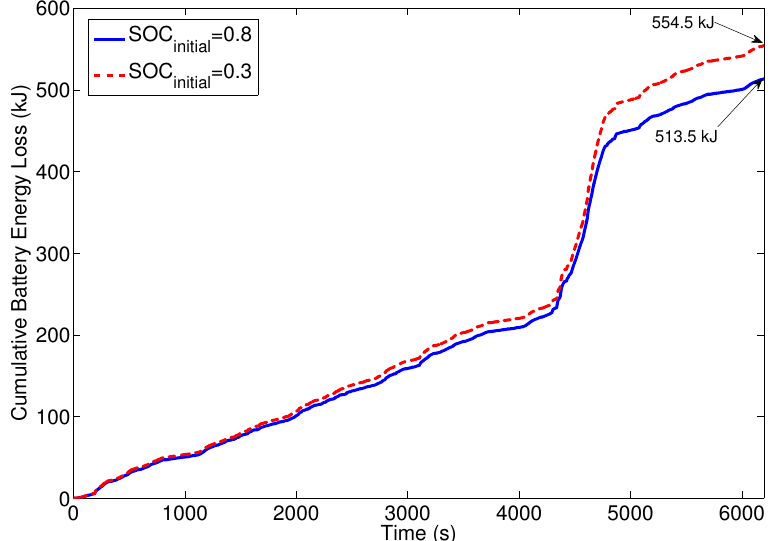
Figure 16. Comparison between battery energy loss for the low SOC initial and high SOC initial operating conditions (EMC: 3-mode